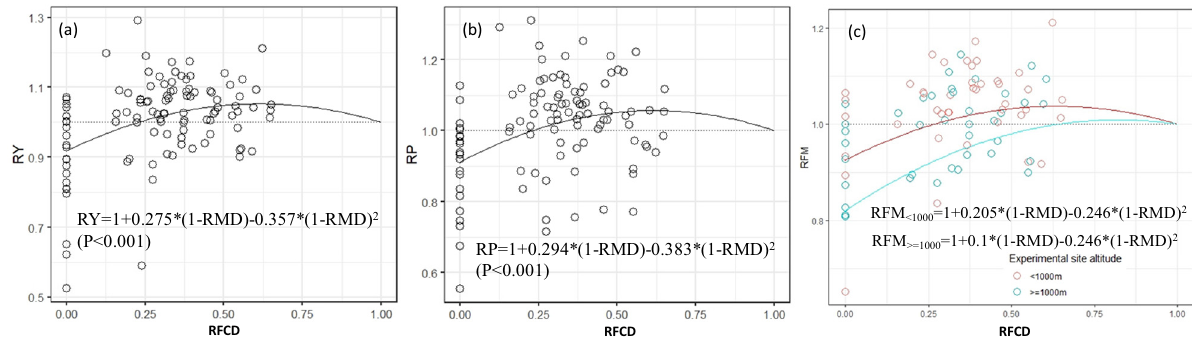
Figure 6: The relationship and model between RY ( a ) , RP ( b ) , RFM ( c ) , and